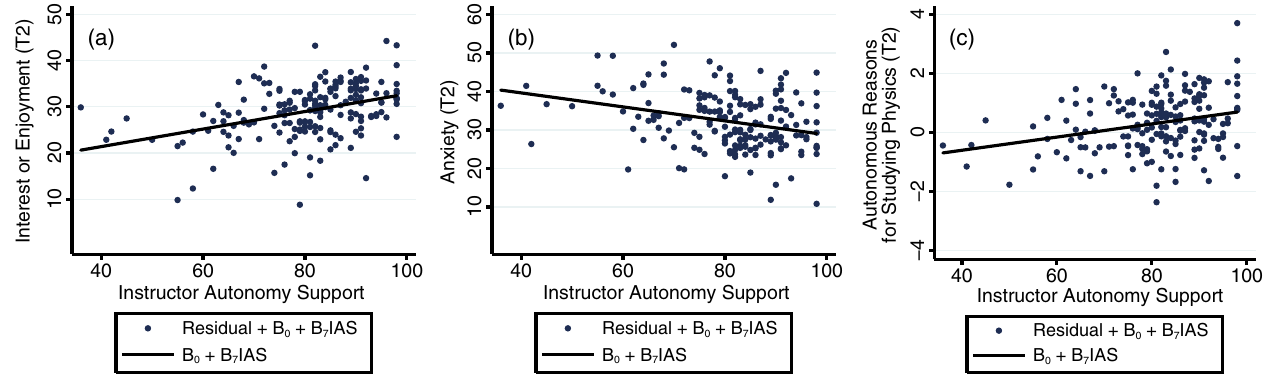
FIG. 2. Component-plus-residual plots for the models of Table V that had (a) Interest/Enjoyment, (b) Anxiety, and (c) relative autonomous reasons for studying physics at the end of the course (T2) as dependent variables, as these were the dependent variables in Table V that depended most significantly on instructor autonomy support as perceived by the students. The slope of the line in each plot is B 7 , the best-fit coefficient of IAS from the multiple regression and thus shows the dependence of the dependent variable on IAS after controlling for the other variables in the model. It is also the best linear fit to the data points, which are the residuals of the full model plus the B 0 and B 7 IAS components of the model. The plots show that students who perceived their instructors as more autonomy supportive tended to become significantly more interested in learning physics and less anxious about taking physics and came to study physics for more autonomous reasons (i.e., more because they wanted to versus had